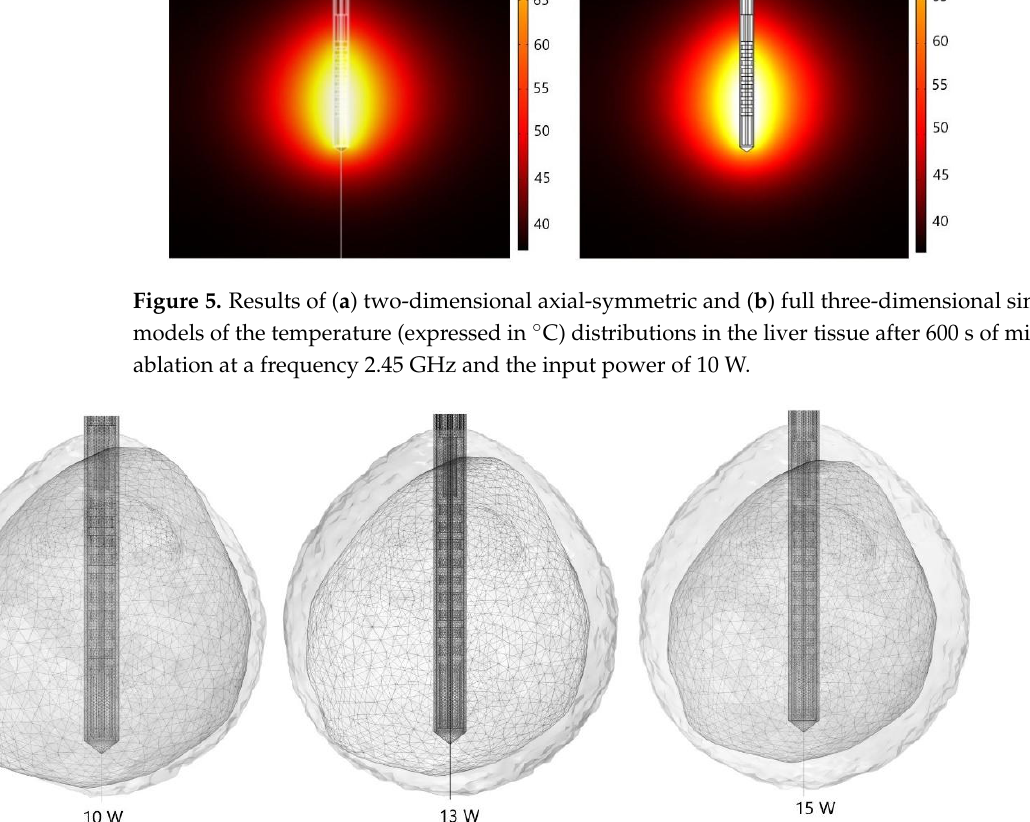
Figure 5. Results of ( a ) two-dimensional axial-symmetric and ( b ) full three-dimensional simulation models of the temperature (expressed in °C) distributions in the liver tissue after 600 s of micro- wave ablation at a frequency 2.45 GHz and the input power of 10 W.